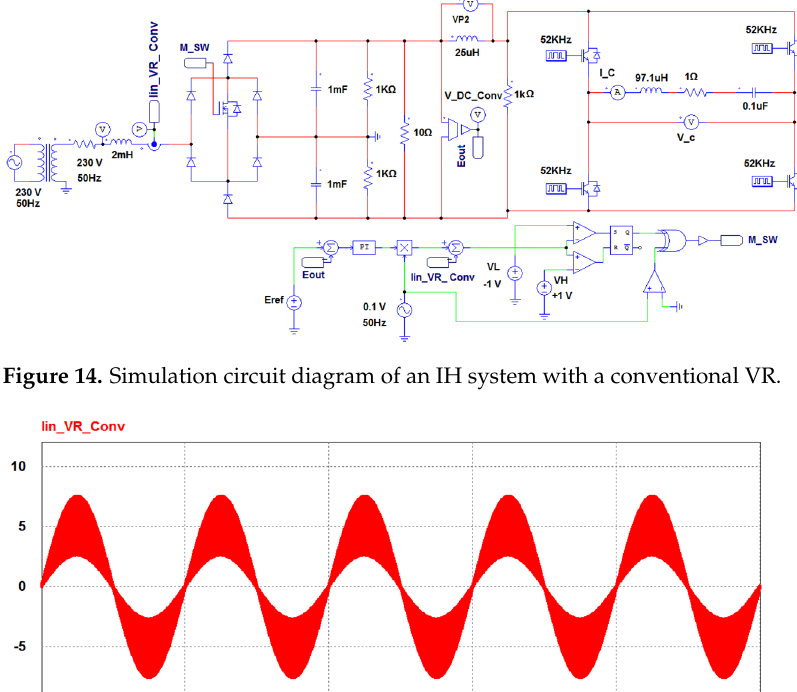
Figure 16. FFT analysis of the input current waveform of an IH system with a conventional VR. Figure 17. Simulation circuit diagram of an IH system with the MVR.